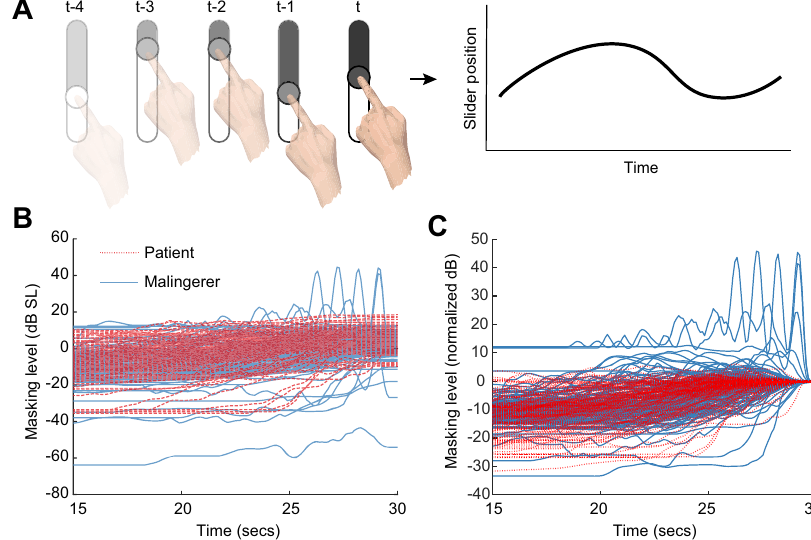
Fig. 4 Minimum masking level (MML) slider position as a function of time for tinnitus patients and malingerers. Only the last 15 s of the track were extracted for further analysis. A Time history of the slider interaction are collected and stored. B Raw fi nger slider position for the MML task. C Normalized fi nger slider position for the MML